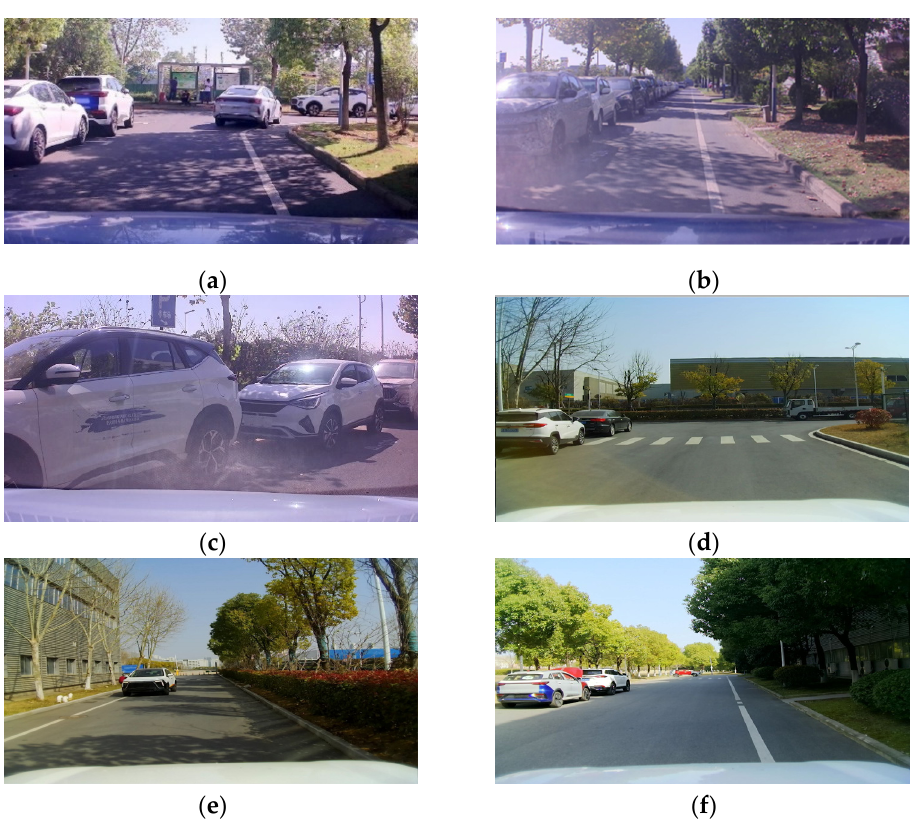
Figure 15. Parts of the test scenario. ( a – f ) include road scenes with different shading conditions and different lighting conditions.